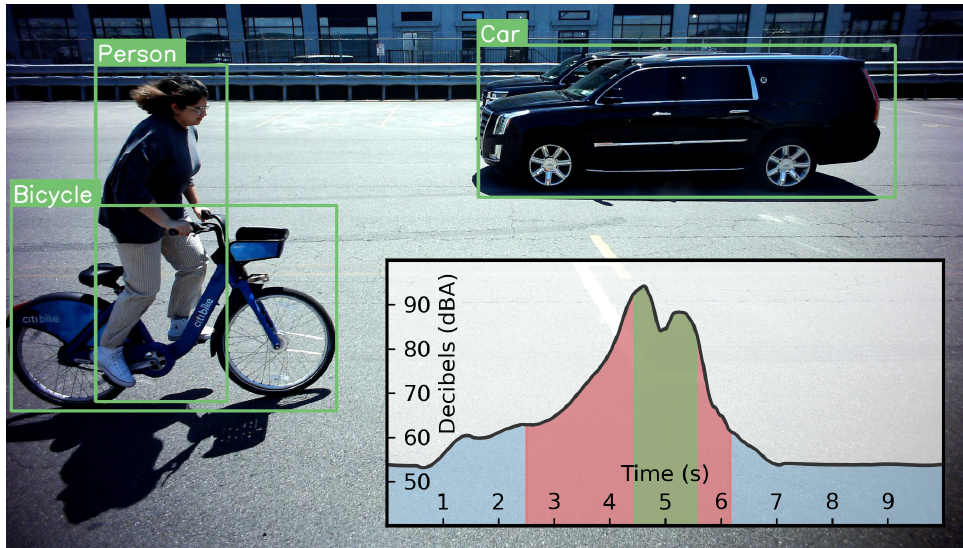
Figure 7. Car and bicycle pass-by frame from sensor’s camera overlaid with bounding boxes and labels from object detection block for illustration. Green region on inset audio amplitude plot shows time period where car is detectable within video frames, with red region showing longer periods of audio-based detection of a car horn. The blue portions signify periods when no audio event was